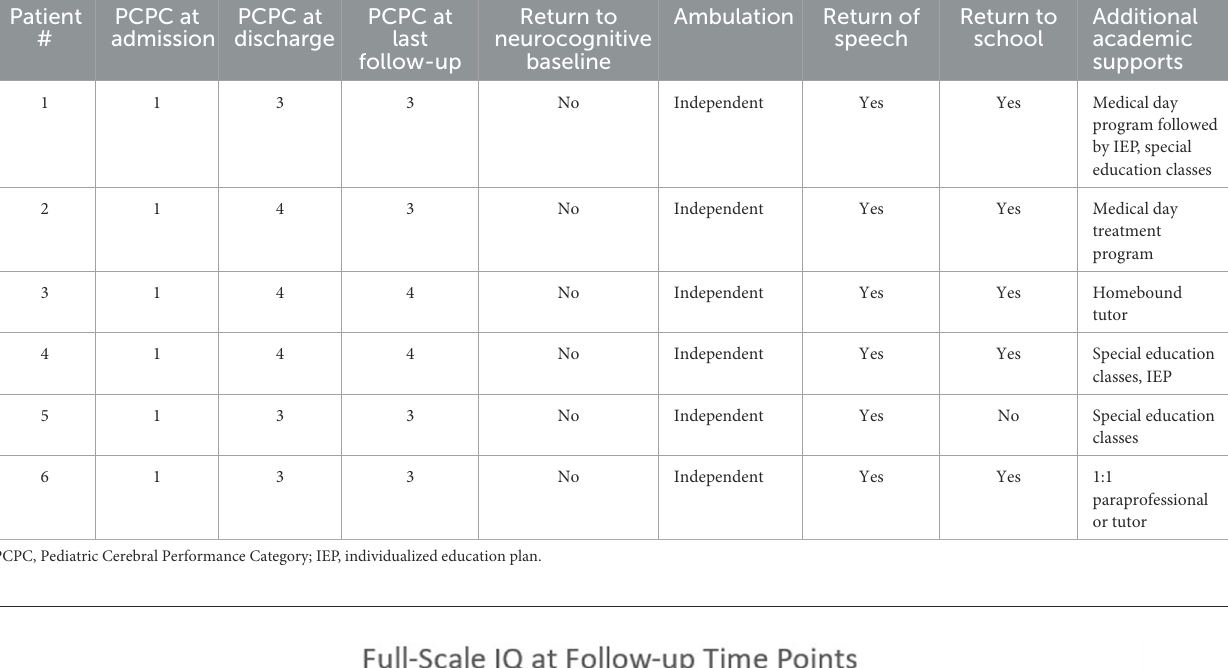
TABLE 2 Patient outcome measures according to physician report.